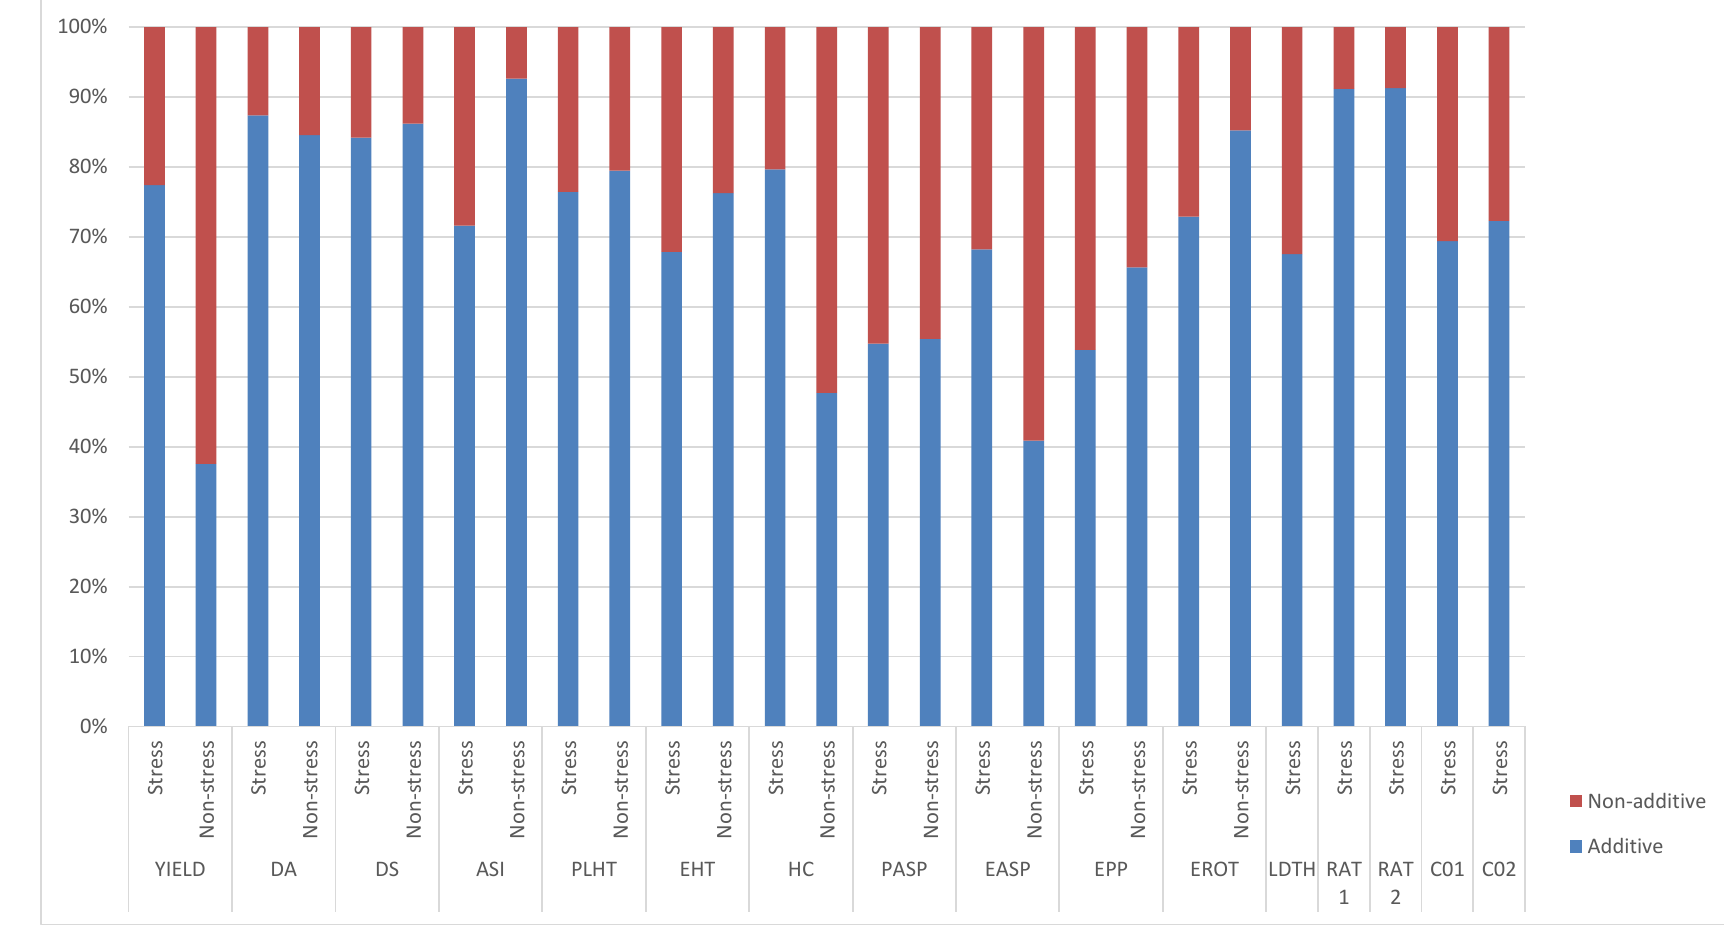
Figure 2. Proportion of additive (lower bar) and non-additive (upper bar) genetic variance for grain yield and other agronomic traits under stress, non-stress, and across test environments in a diallel among 20 early pro-vitamin A inbred lines.